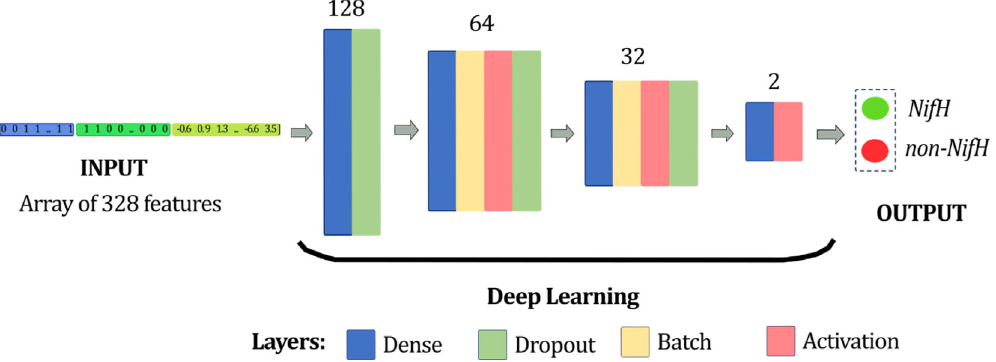
Figure5.Visualisationofthedeepneuralnetworkarchitecture. Itwascomposedoffourblocks,andthenumber of neurons for each block was 128, 64, 32, and 2, from the first to last one,